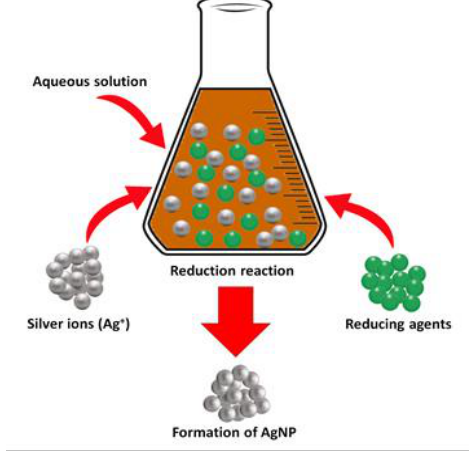
Fig. 2. Chemical synthesis of silver nanoparticles (AgNPs). Adopted from